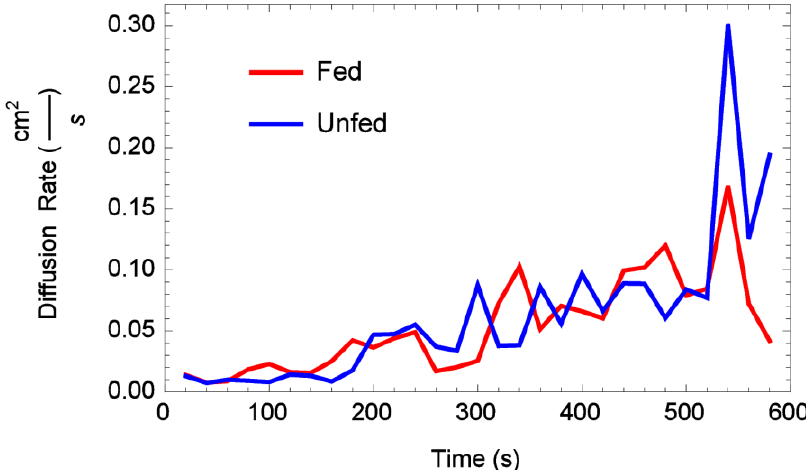
Figure 8. Estimated mean diffusion rate through time, fed vs. unfed bed bugs, two-dimensional